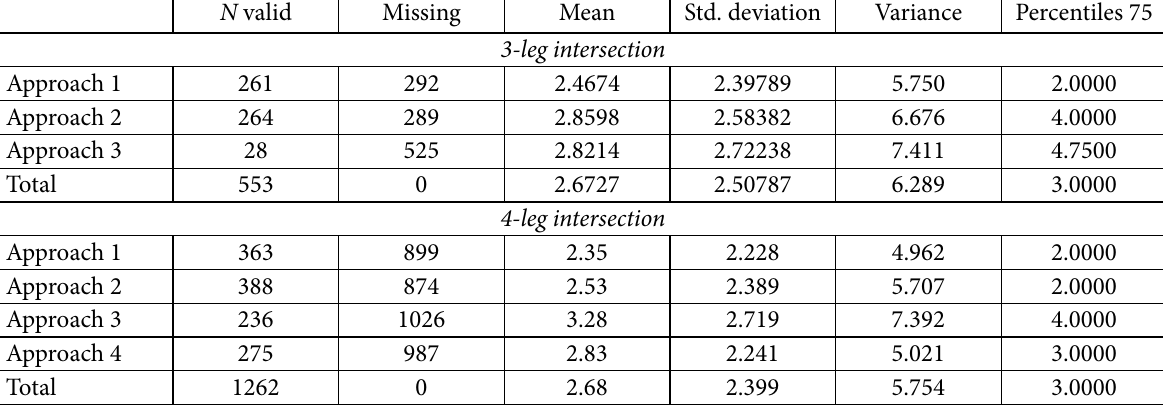
Table 9. Descriptive and 75th percentile of RLR second after red-light onset N